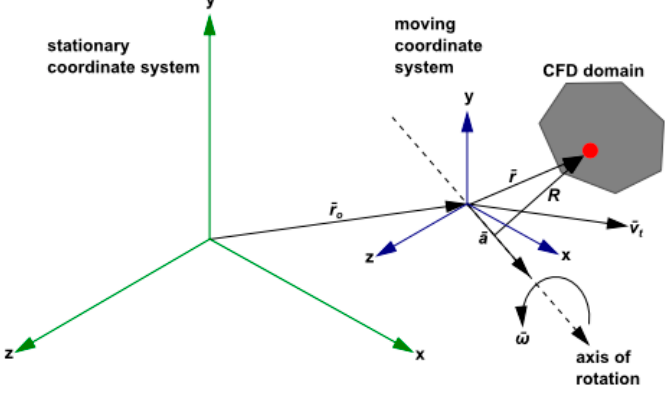
Figure 23. Stationary and Rotating Reference Frames.